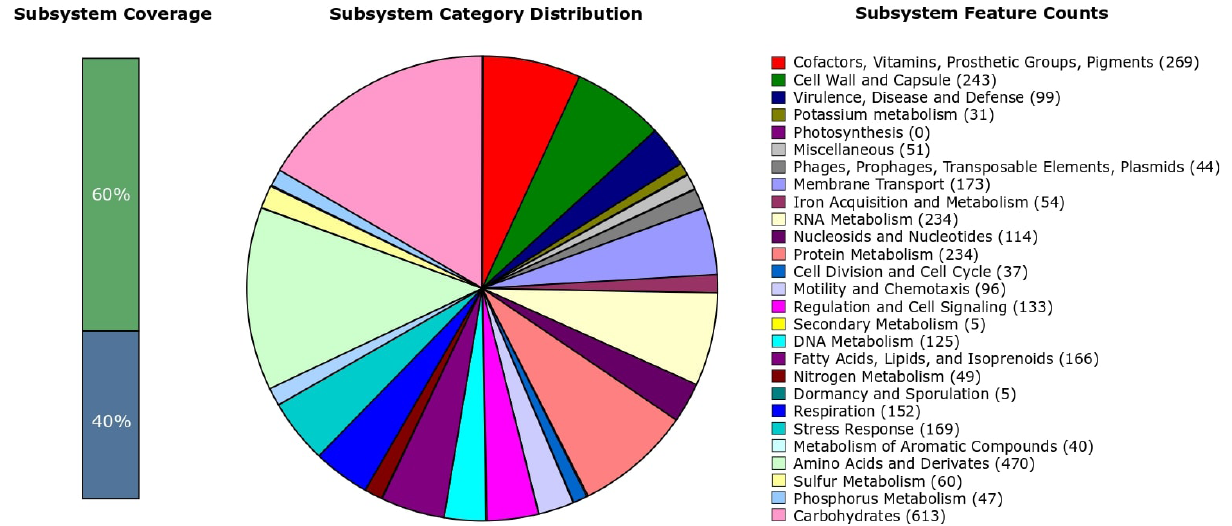
Figure 2 – Functional analyses of L adecarboxylata strain Palotina